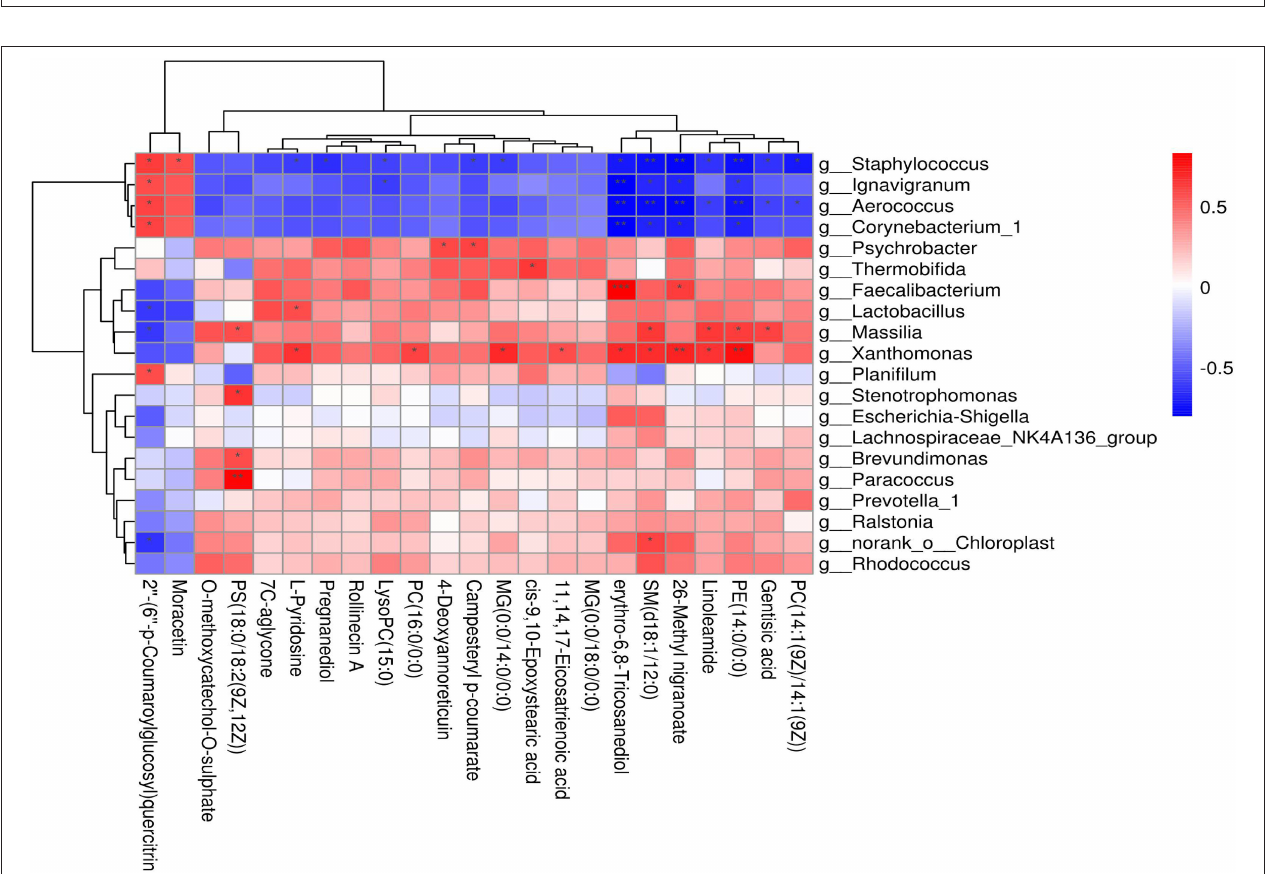
FIGURE 7 | Kyoto encyclopedia of genes and genomes pathway enrichment analysis based on the changed metabolites between the CON and AOB groups. * p < 0.05, ** p < 0.01, *** p < 0.001; Fisher’s exact test with BH correction. KEGG, Kyoto encyclopedia of genes and genomes.